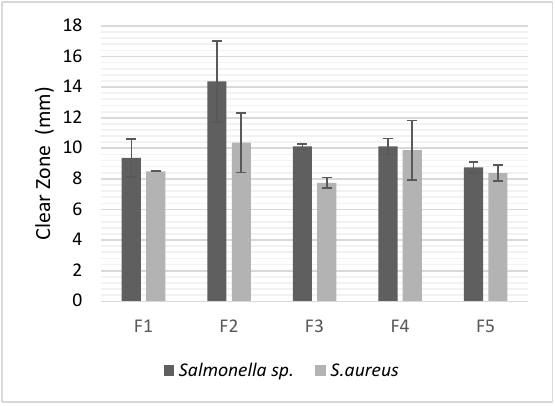
Figure 3. Antimicrobial activity of purified fraction .